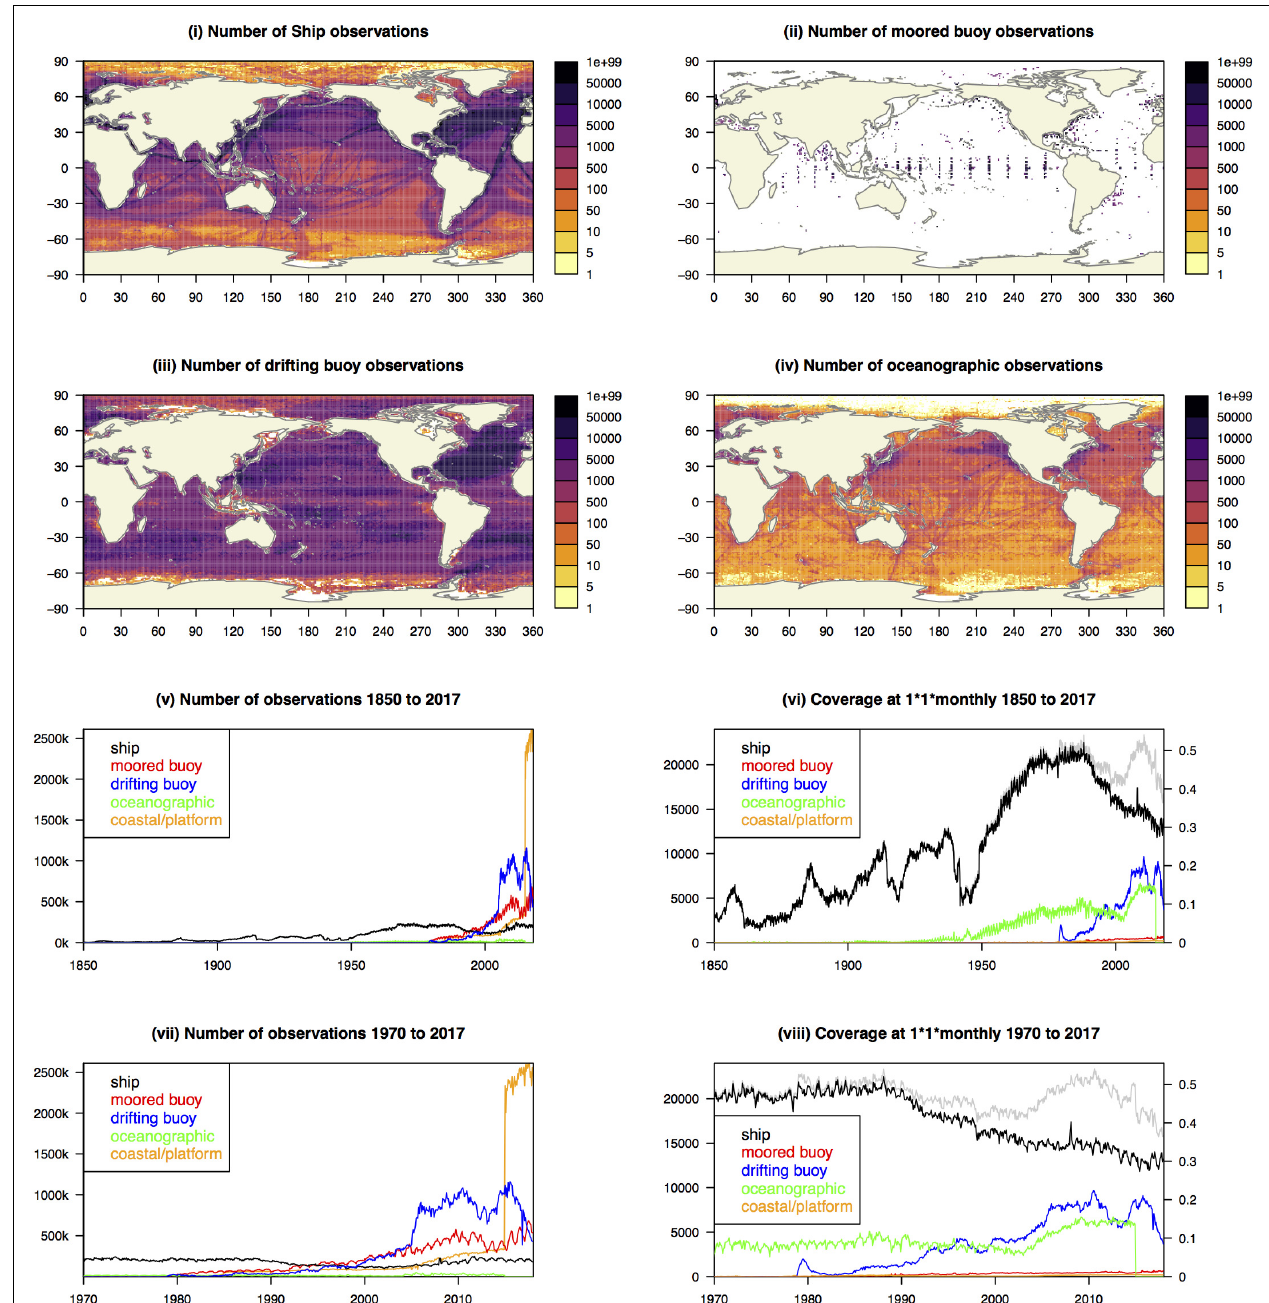
FIGURE 3 | Number of observations between 1850 and 2017 (as Figure 2 ) but by ICOADS platform type (PT): ships (PT 0-5); moored buoys (PT 6), drifting buoys (PT 7), oceanographic observations (PT 10-12, 19-21), and coastal and other platforms (9, 13-16). Note that some missing PT have been estimated based on data sources. The gray line in panels vi and viii shows the coverage across all platforms. Panels vii and viii show the same information as v and vi but starting in 1970. Oceanographic data are ingested into ICOADS in delayed mode, data for 2015 onwards will be ingested in the next ICOADS